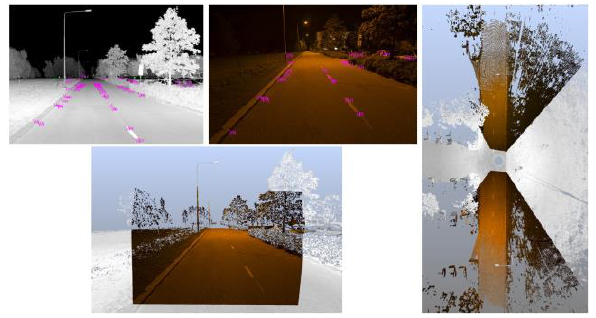
Figure 5. The relative orientation between undistorted RGB images and intensity images of terrestrial laser scans.